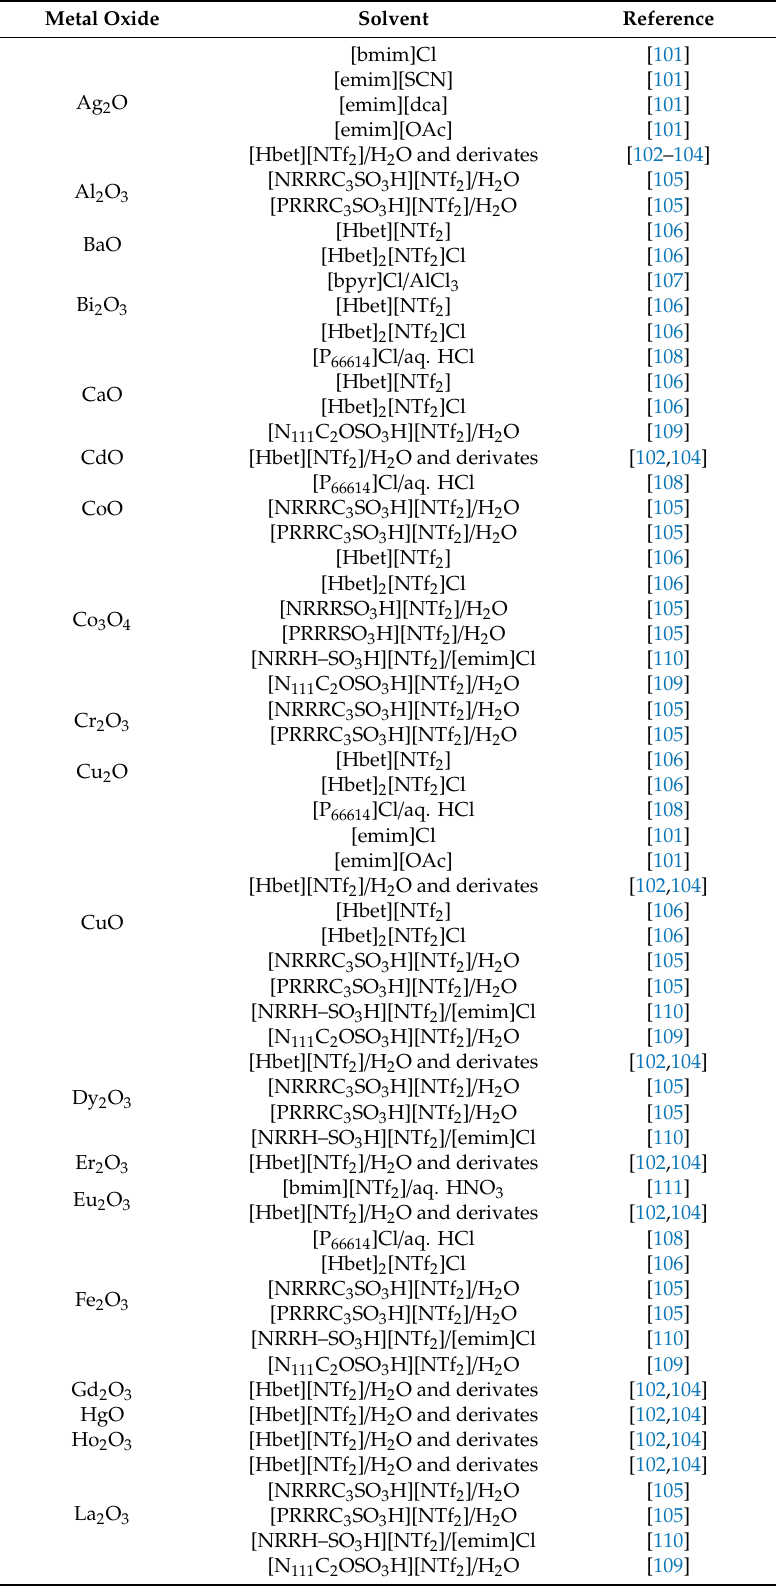
Table 2. Overview about metal oxides dissolved in di ff erent ILs as well as corresponding